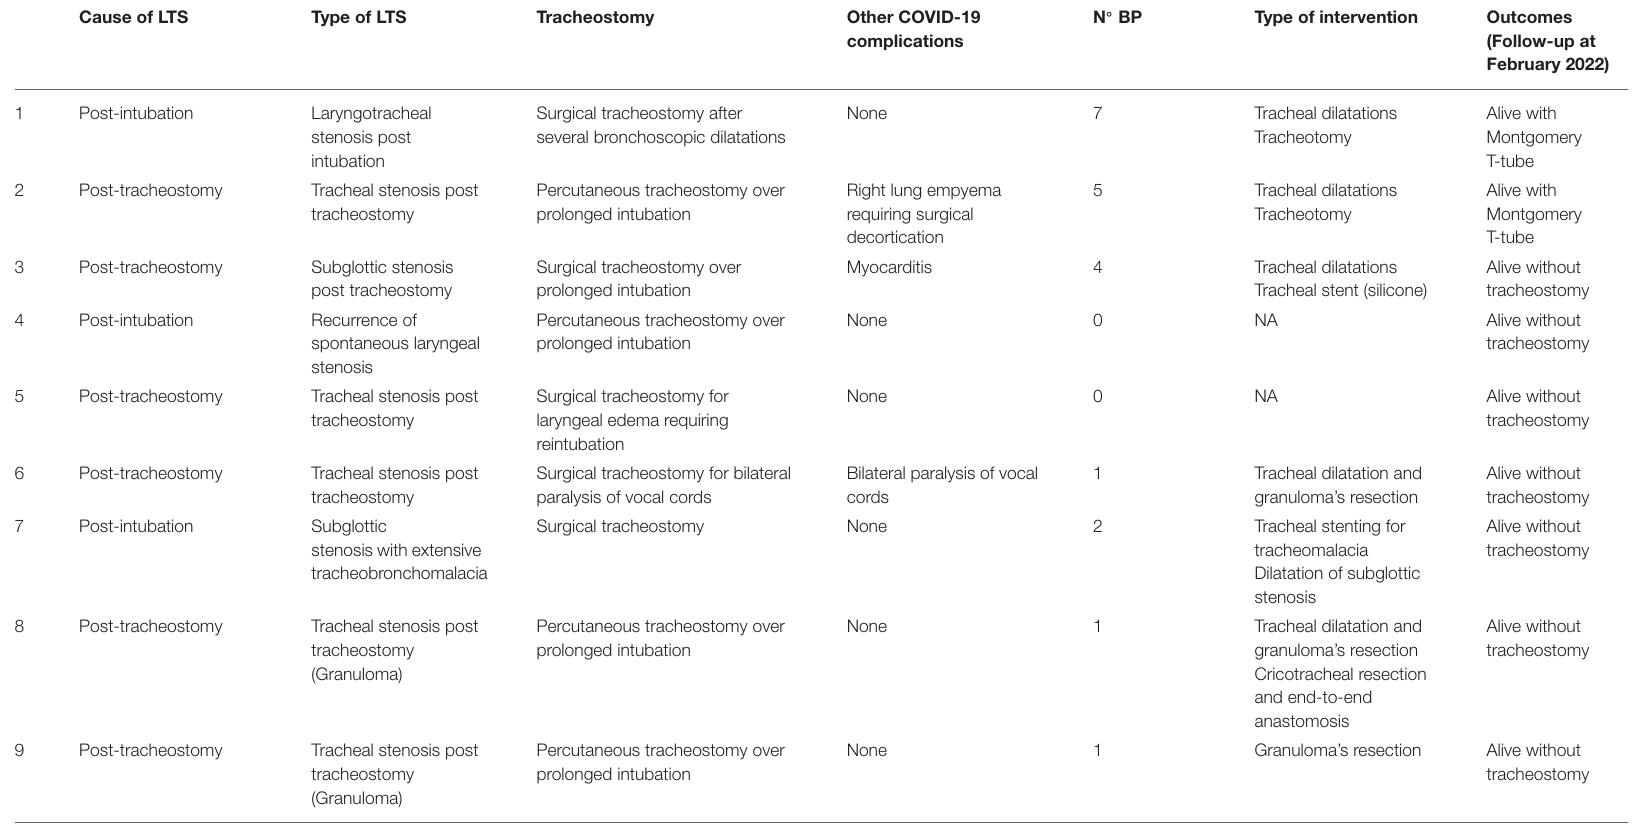
TABLE 2 | Details of LTS, treatment and patients’